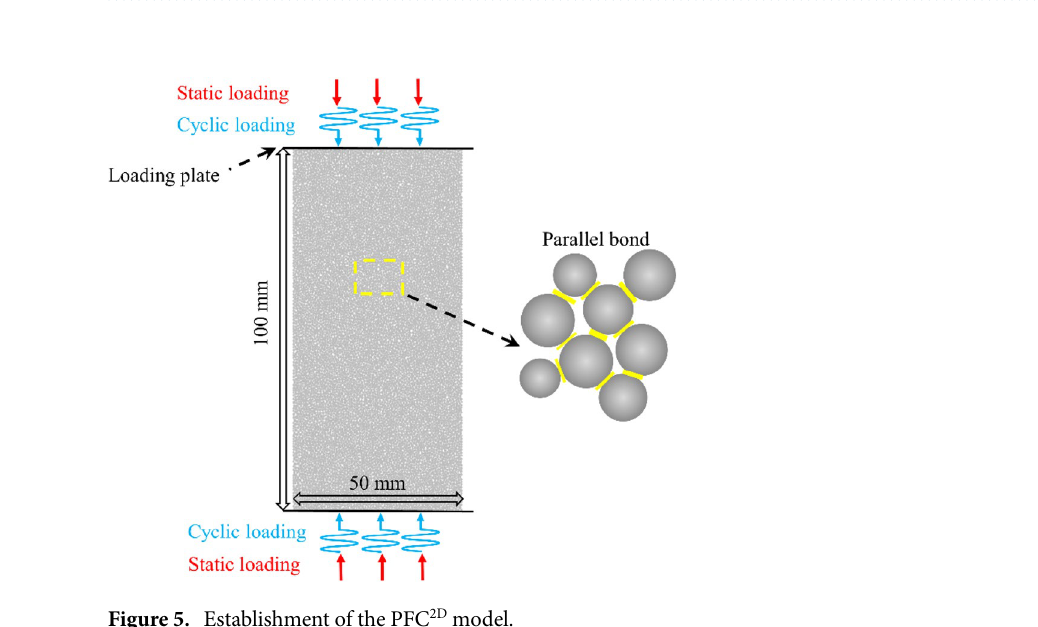
Figure 5. Establishment of the PFC 2D model.